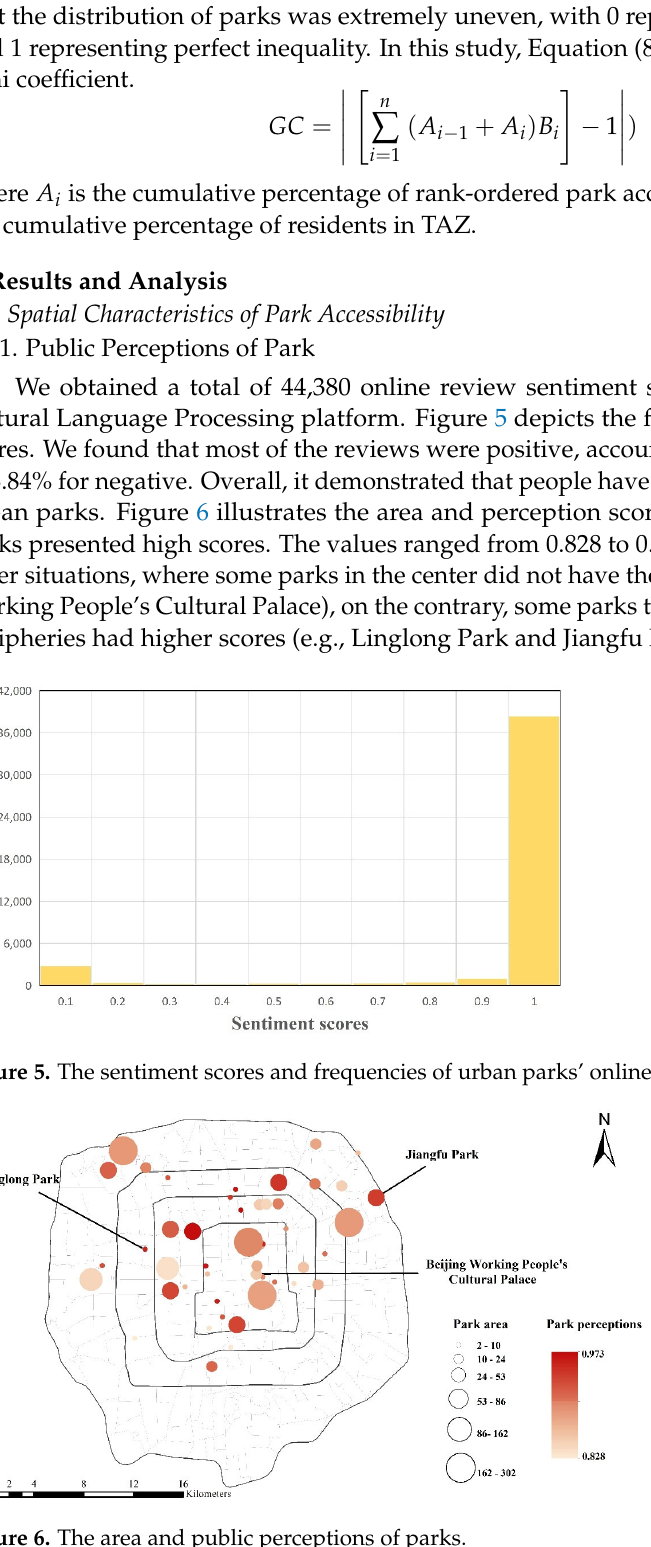
Figure 6. The area and public perceptions of parks.